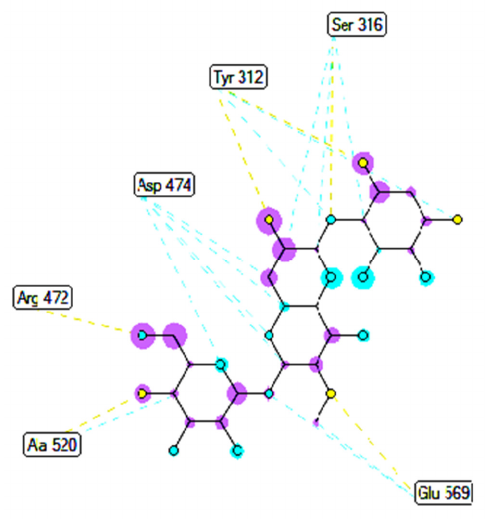
Figure 24. Ligand map revealing the secondary interactions formed from active atoms on pose 172, a standard drug apramycin, to residual amino acids on enzyme 2VF5.